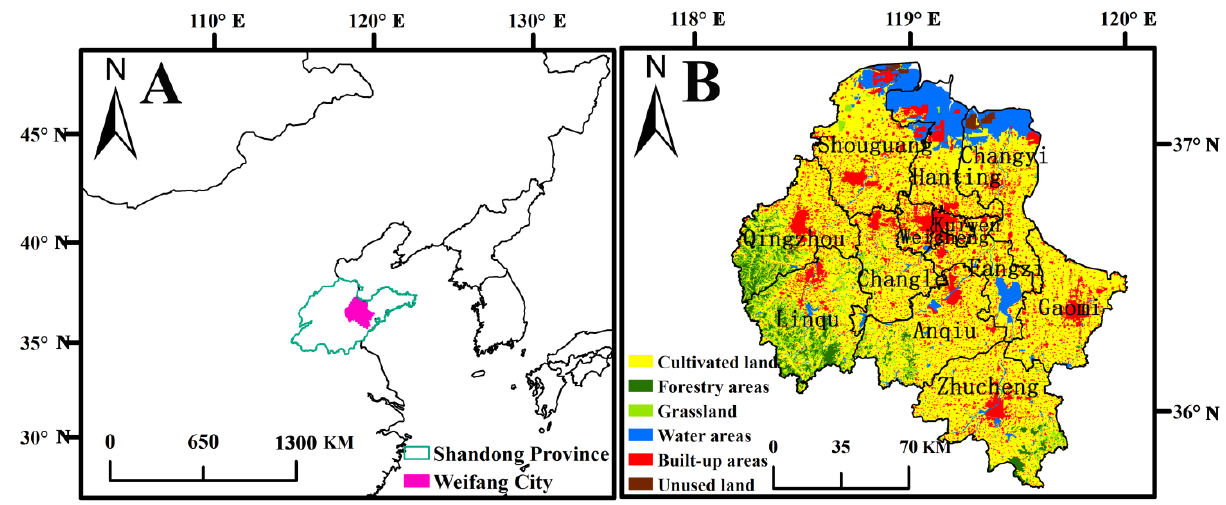
Figure 1. Geographical location of Weifang city ( A ) and the distribution of its land use types in 2015 ( B ).